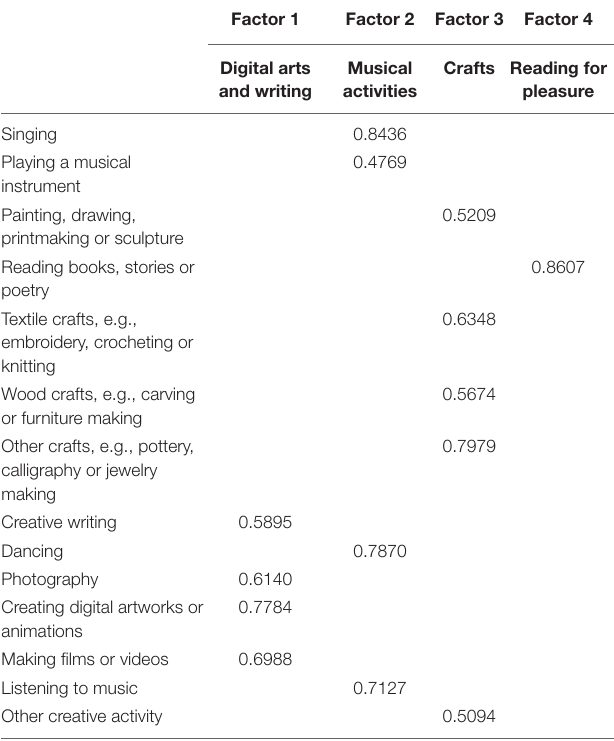
TABLE 1 | Tetrachoric factor analysis for types of arts activities during the COVID-19 pandemic in the United